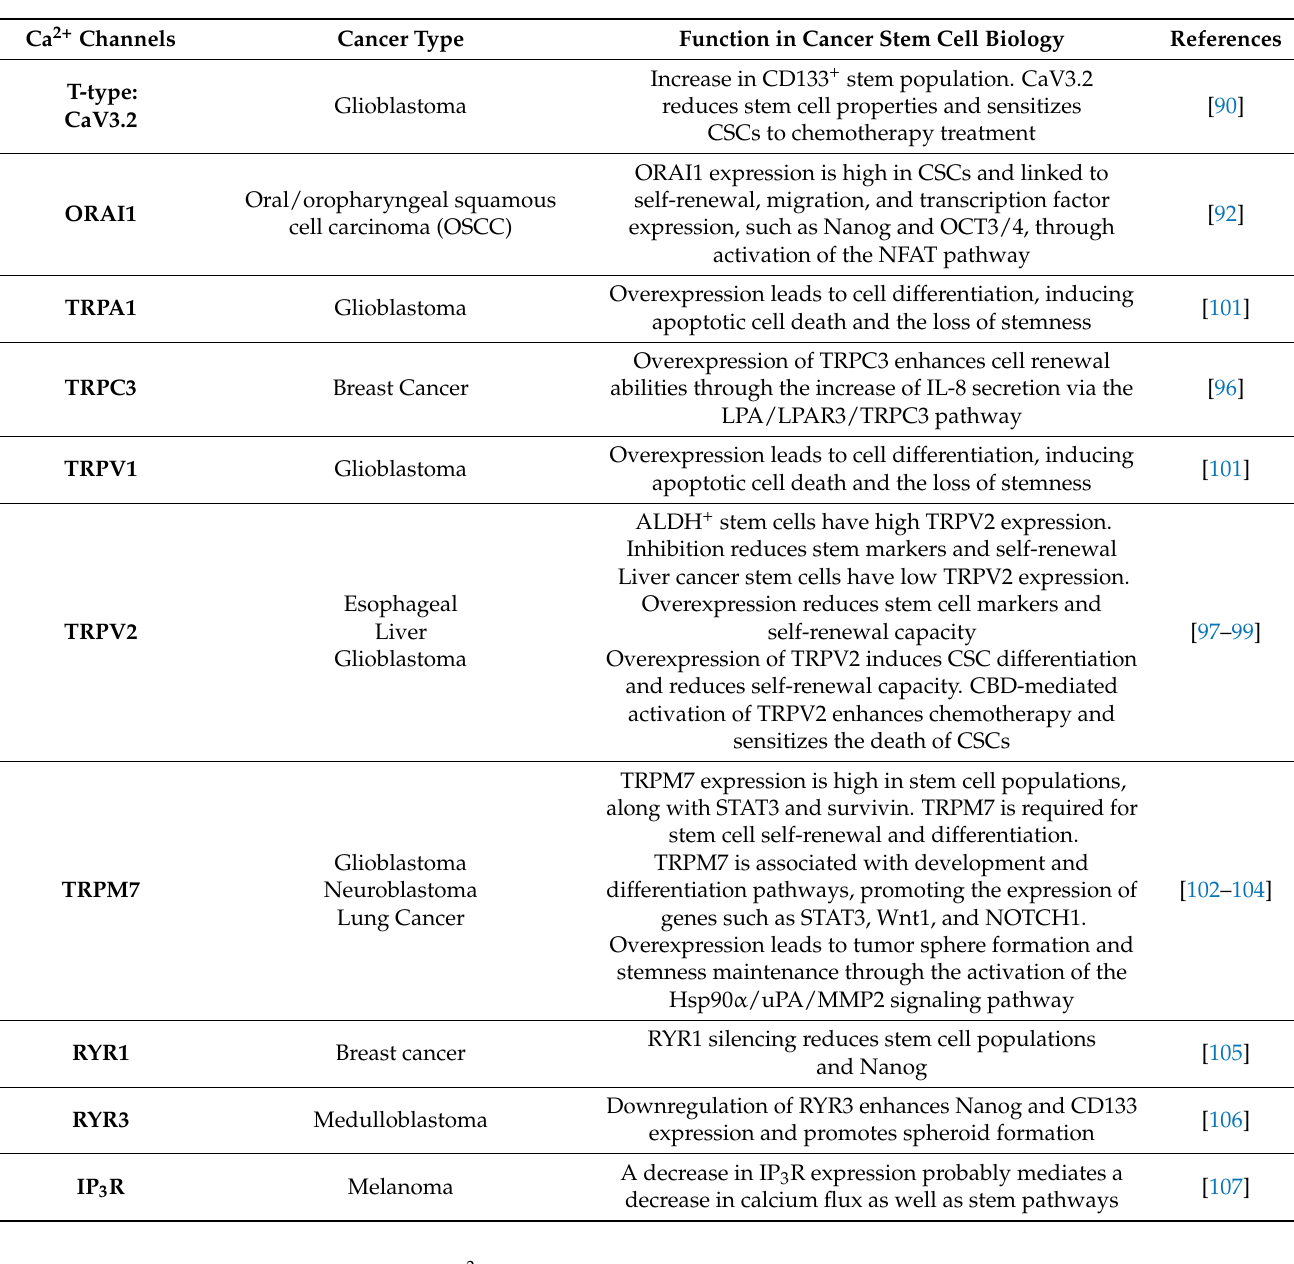
Table 2. Roles of Ca 2+ and Ca 2+ channels in cancer